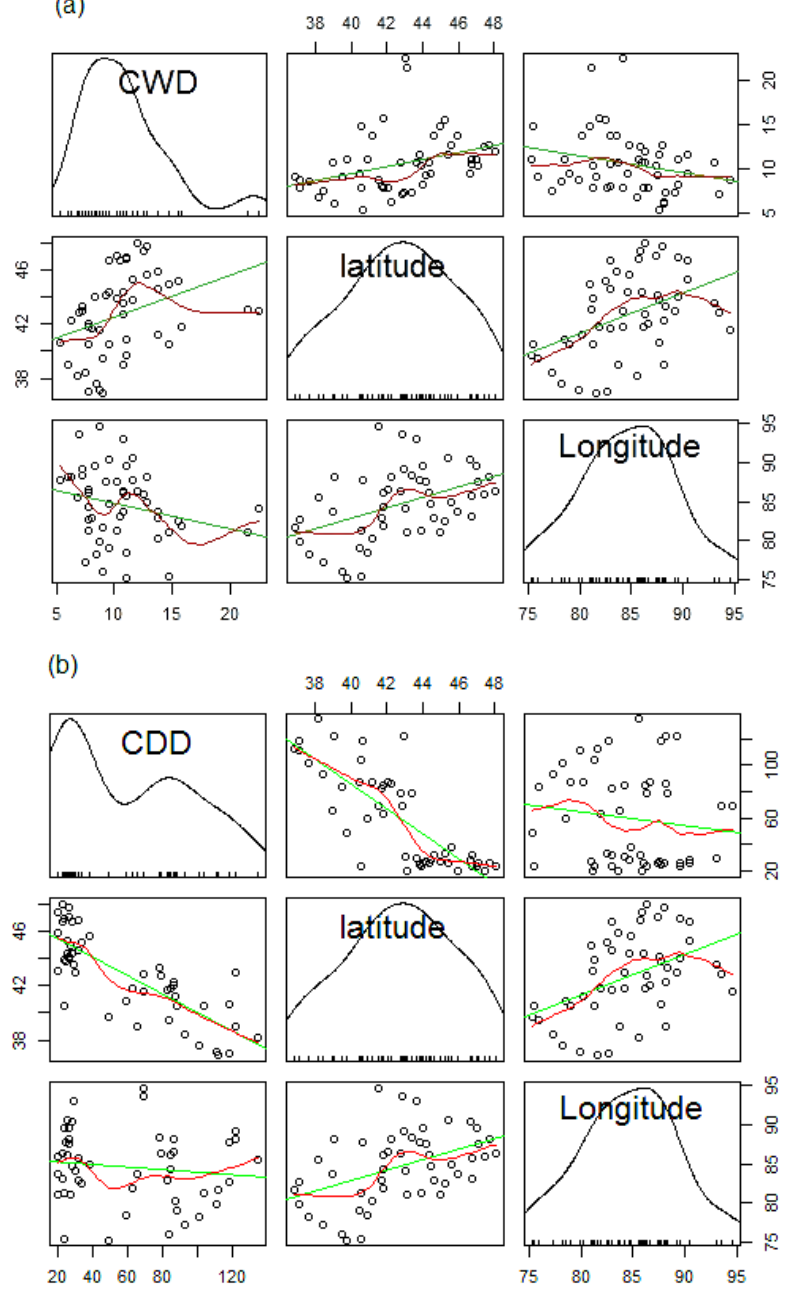
Fig. 5. Scatter plots of (a) CWD and longitude-latitude, (b) CDD and